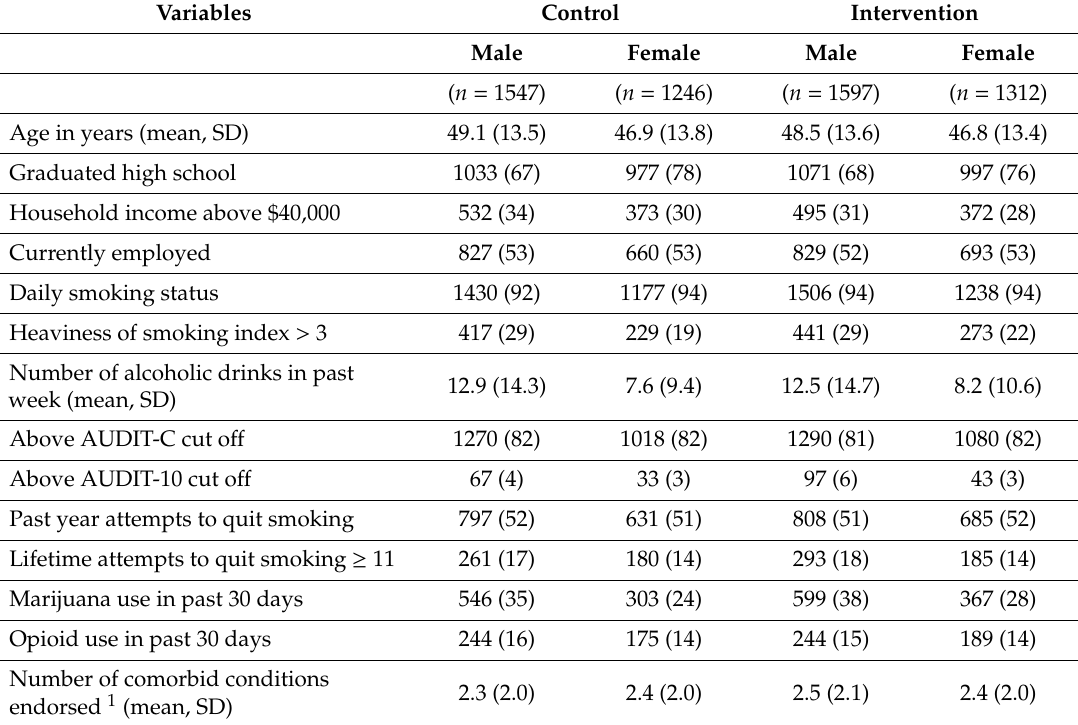
Table 1. Baseline patient characteristics for the main analytic sample ( n =